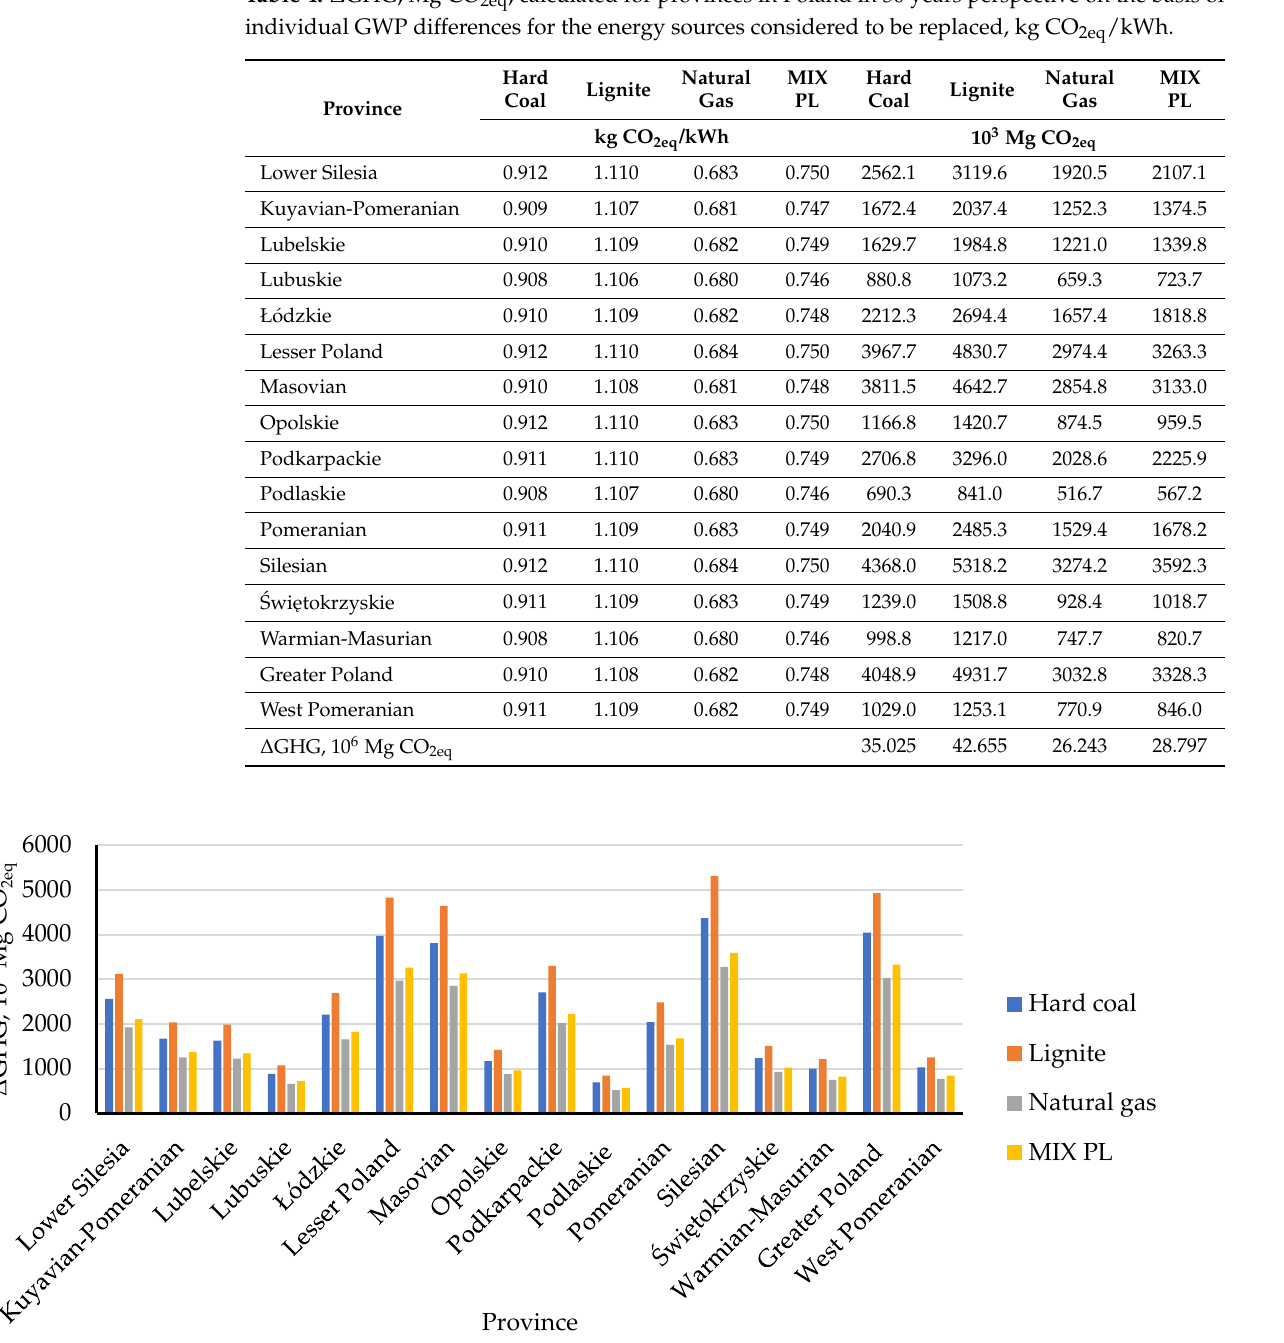
∆ GHG, 10 3 Mg CO Figure 9. ΔGHG, 10 3 Mg CO 2eq in four scenarios of replaced energy source. Figure 9. 2eq in four scenarios of replaced energy